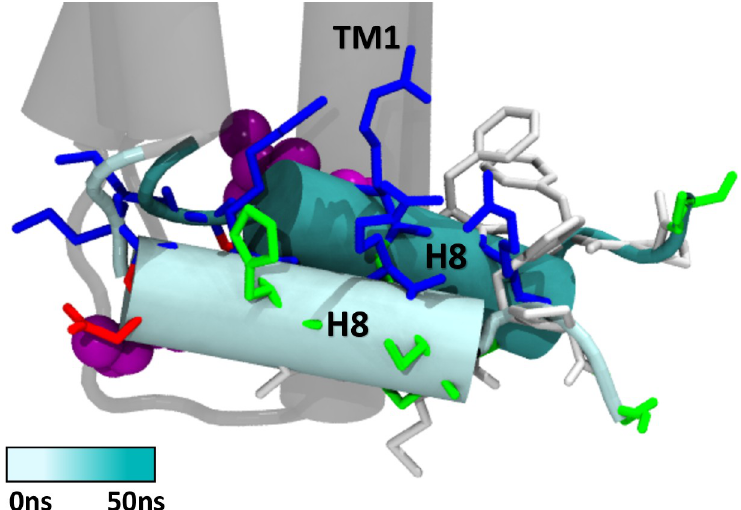
Fig 11. Movement of helix 8 in the active conformation of the CB 1 R throughout 50 ns of simulation. Residue type is indicated in color code: acidic residues (red), basic residues (blue), polar residues (green) and non-polar residues (white). L404 is shown in vdW representation